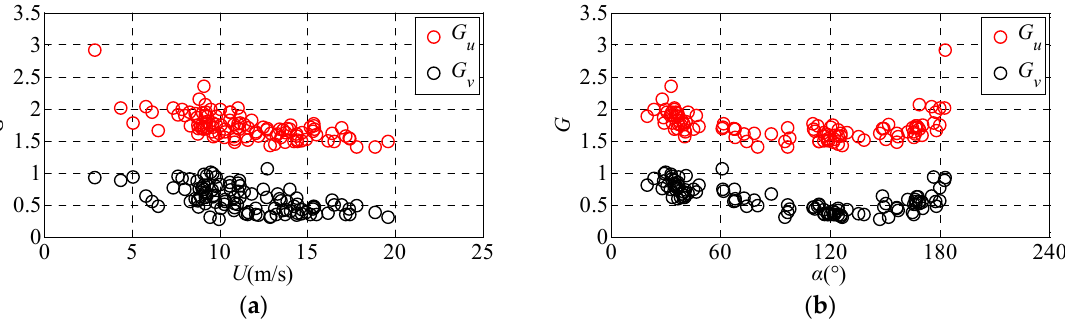
Figure 9. The variation of gust factor with respect to 10-min wind speed and direction. ( a ) G u , v with respect to 10-min U ; ( b ) G u , v with respect to 10-min α